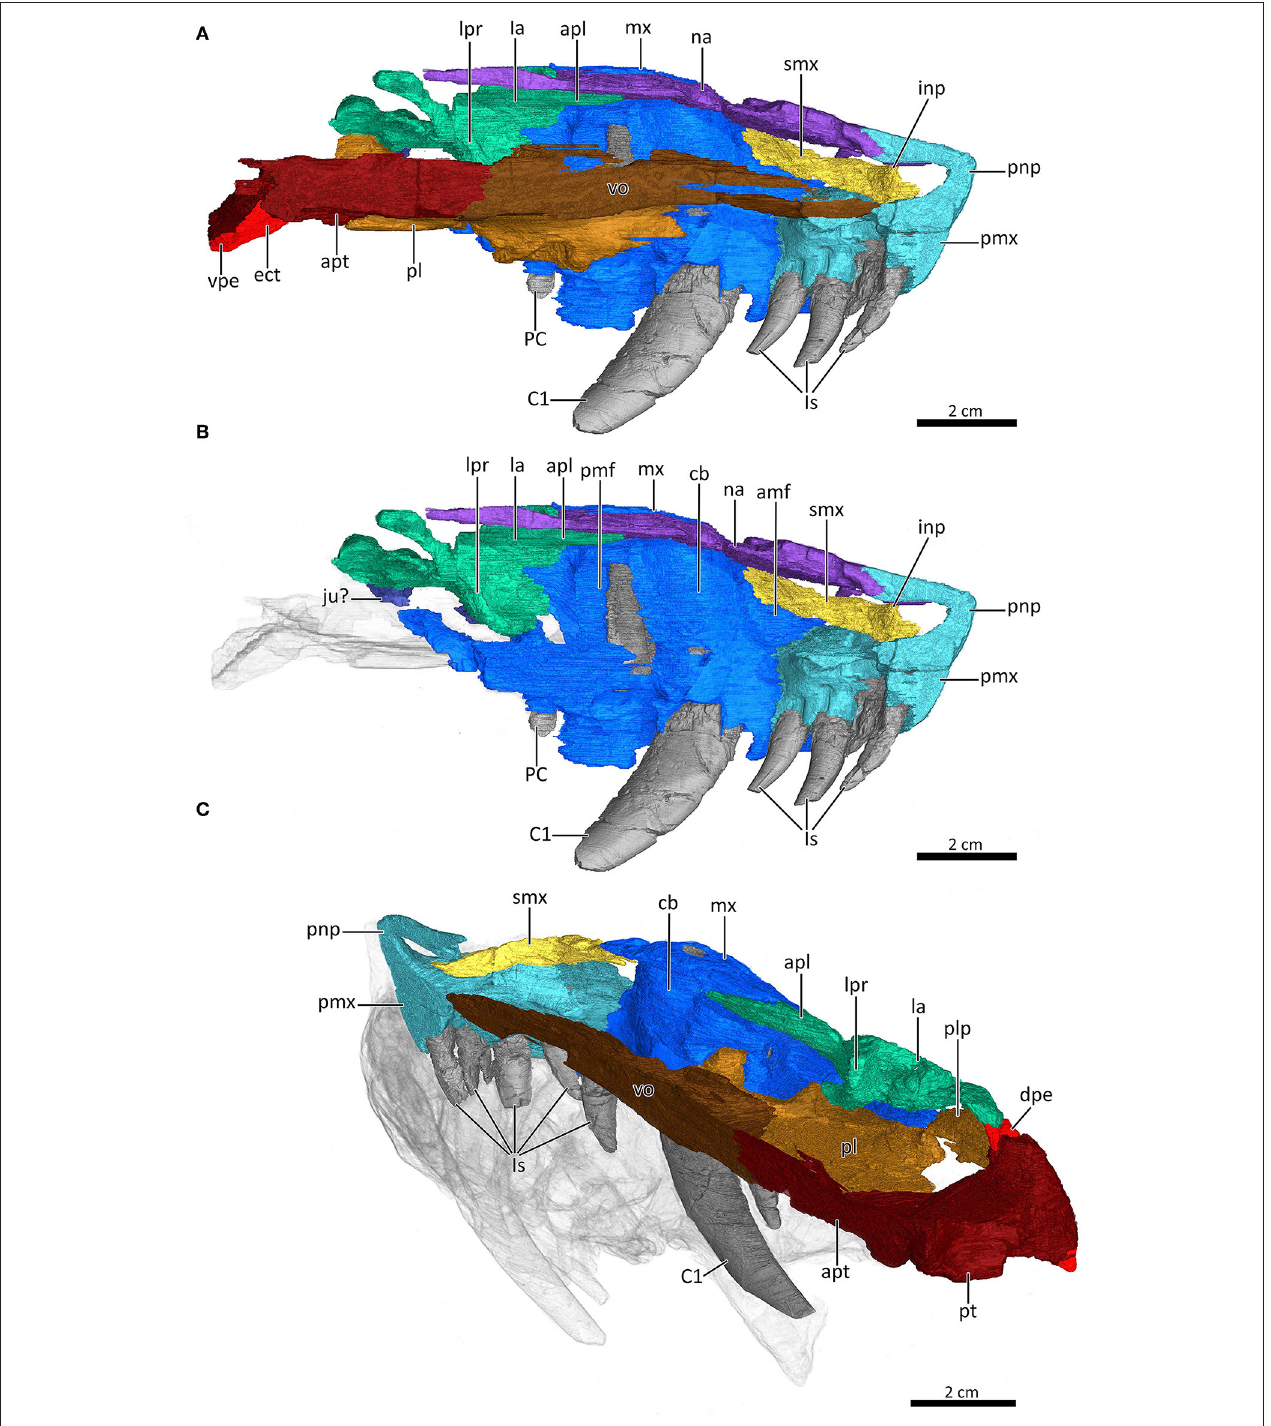
FIGURE 7 | Mid-sagittal section through the reconstructed snout of MB.R.995 to show its internal morphology. (A,B) Internal view of the left nasal region with the vomer, palatine, and ectopterygoid digitally removed in (B) to expose the internal structure. (C) Internal morphology of the right nasal region in posterodorsolateral view with the nasal digitally removed to expose the internal structure. amf, anterior maxillary fossa; apl, anterior process of the lacrimal; apt, anterior process of the pterygoid; C1, first canine; cb, canine boss; dpe, dorsal process of the ectopterygoid; ect, ectopterygoid; inp, intranarial process; Is, upper incisors; ju?, jugal?; la, lacrimal; lpr, lacrimo-palatine ridge; mx, maxilla; na, nasal; PC, upper postcanine; pl, palatine; plp, posterolateral process of the palatine; pmf, posterior maxillary fossa; pmx, premaxilla; pnp, prenasal process of the premaxilla; pt, pterygoid; smx, septomaxilla; vo, vomer; vpe, ventral process of the ectopterygoid.